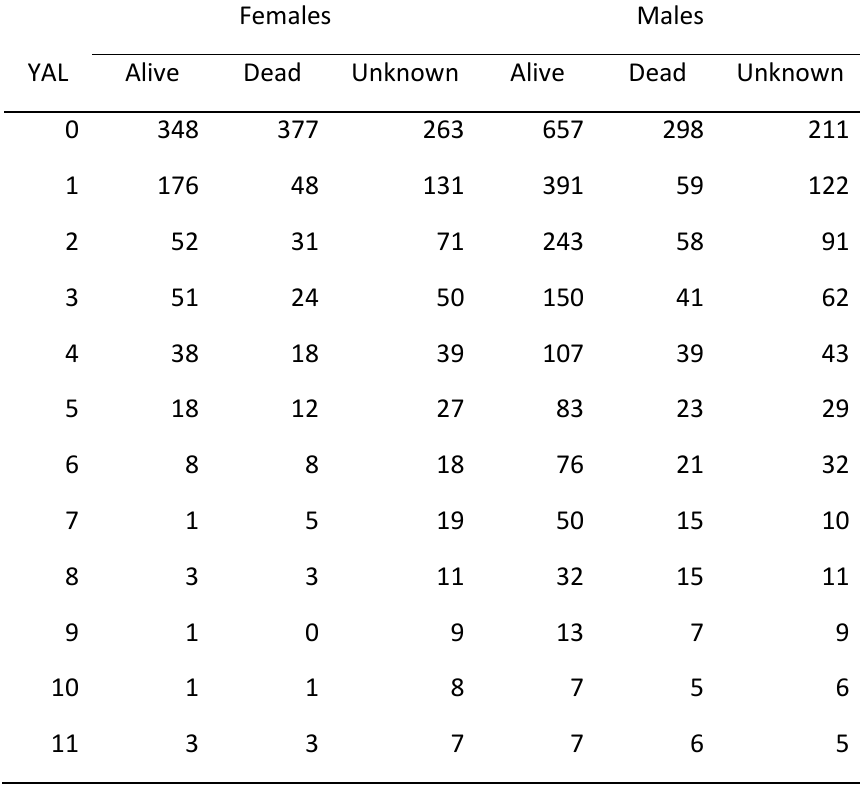
Table 19. Total recaptures by years at large (YAL) for all trawl captured, bled male and female horseshoe crabs since 1999.